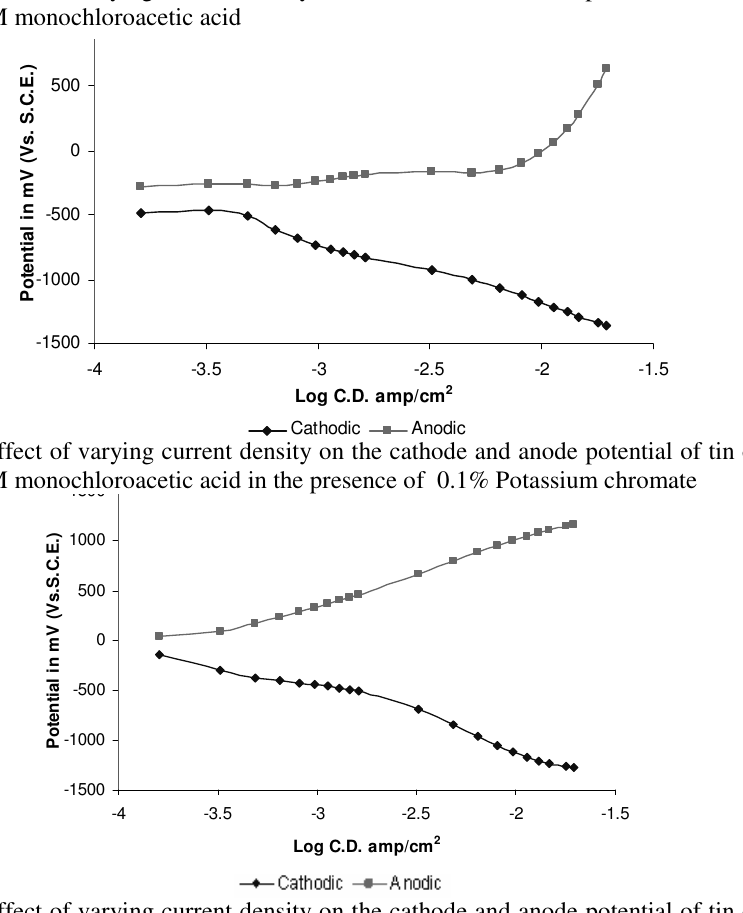
Figure 3 . Effect of varying current density on the cathode and anode potential of tin coated steel in 0.5M monochloroacetic acid in the presence of 0.5% Potassium